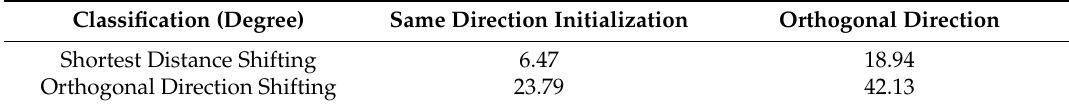
Table 6. Performance evaluation for motion